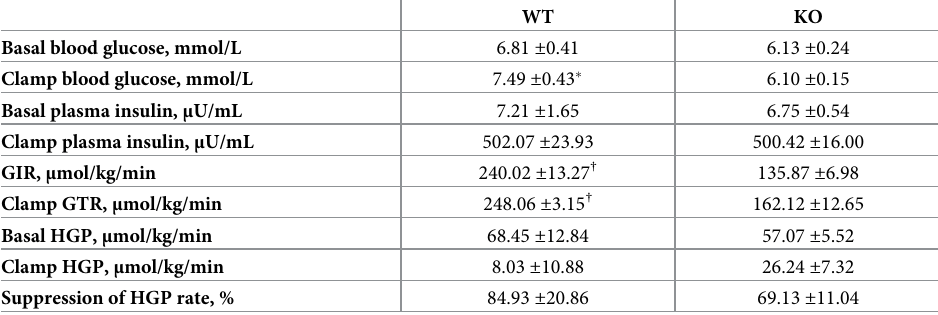
Glucose infusion rate = GIR. Glucose turnover rate = GTR. Hepatic glucose production = HGP. Means ± SEM for 4 rats of each genotype: WT = wildtype, and KO = AS160-KO. � P 0.05, † P < 0.001, WT versus